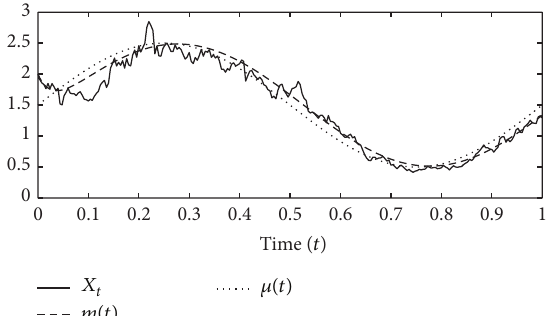
Figure 1: Dynamic behavior for 𝑚(𝑡) , 𝜇(𝑡) , and 𝑋 𝑡 , where 𝑋 0 = 2 , 𝛼 = 37 , 𝜎 = 0.7 , 𝛾 = 1 , 𝑎 = 1.5 , 𝑏 = 1 , 𝑃 = 1 , and 𝛽 = 2𝜋 with Δ𝑡 = 1/250 for a total of 250